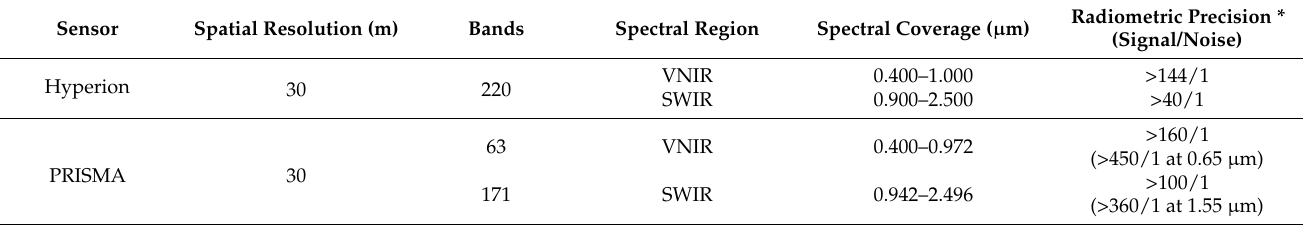
Table 2. The characteristics of the Hyperion and PRISMA